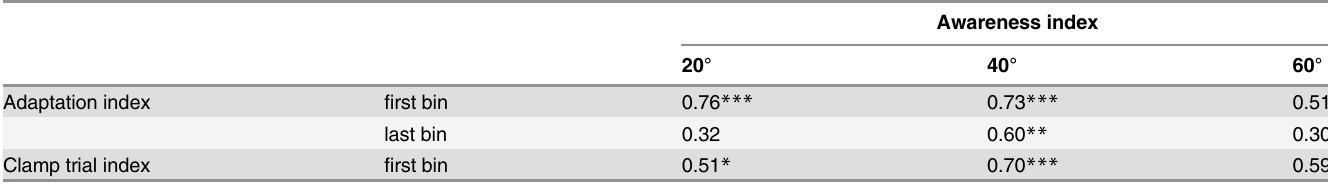
Pearson product-moment correlation coef fi cients of the correlations between awareness and adaptation ( fi rst and last bin) or clamp trial indices ( fi rst bin) are shown, respectively. Symbols *** , ** , and * indicate p < 0.001, p < 0.01, and p < 0.05, respectively, and the absence of a symbol indicates p >